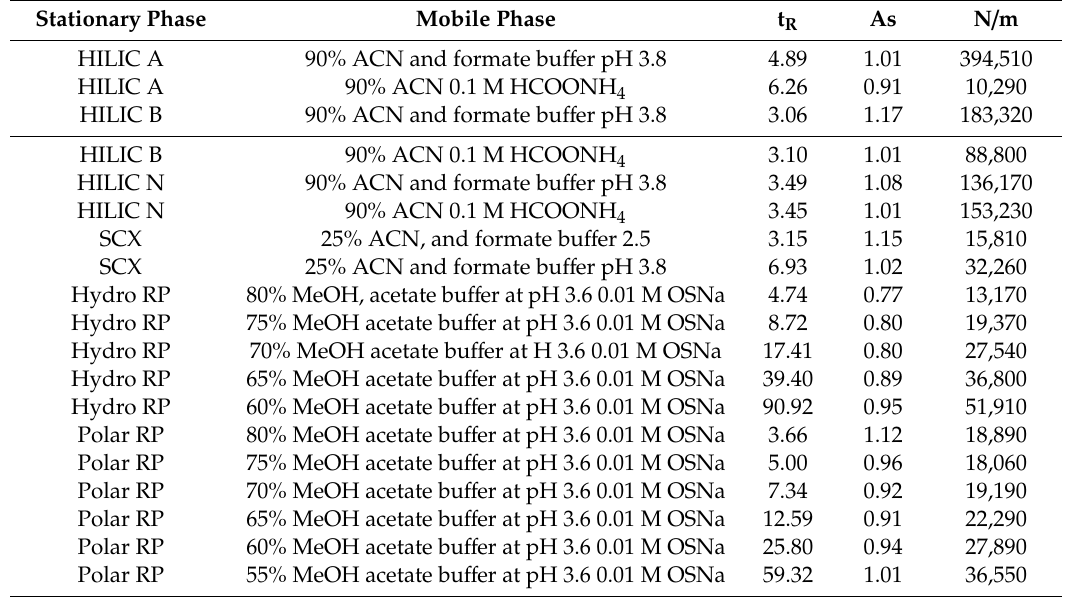
Table 1. Values of t R , log k, A S , and N / m obtained for vortioxetine in various chromatographic